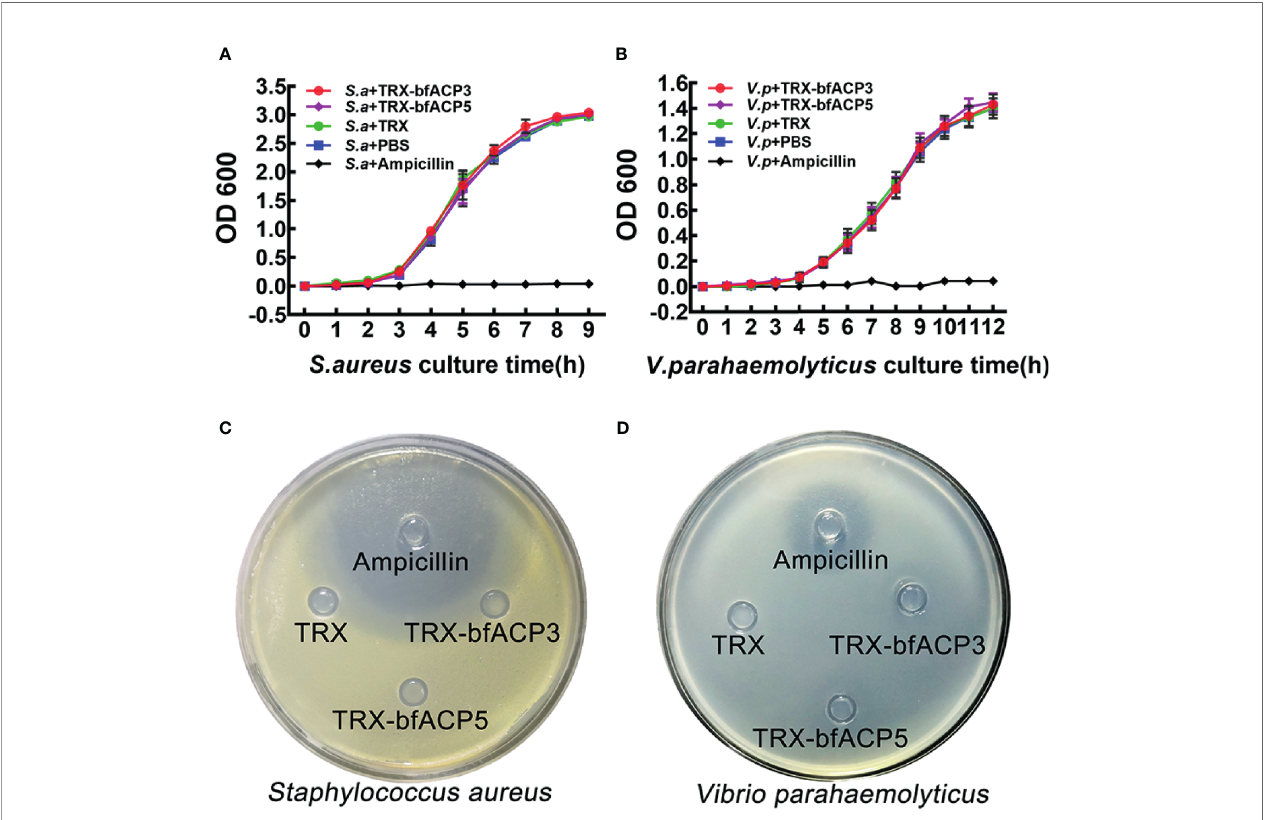
FIGURE 4 | BfACP3 and bfACP5 are not antibacterial against S. aureus and V. parahaemolyticus. Growth curves of S. aureus (A) and V. parahaemolyticus (B) in the presence of TRX-bfACP3 or TRX-bfACP5 in medium while being shaken. OD 600 was measured every 1 h after starting the culture (mean ± SD, n = 3). Oxford Cup experiments cultured with S. aureus (C) or V. parahaemolyticus (D) were performed with 100ul Ampicillin (100 m g/mL), TRX (0.2 m g/ m l), TRX-bfACP3 (0.2 m g/ m l) and TRX-bfACP5 (0.2 m g/ m l). Then, the plates were incubated at 37°C for 16 h ( S. aureus ) or 28°C for 40 h ( V. parahaemolyticus ). A transparent ring around the cups signi fi es antibacterial